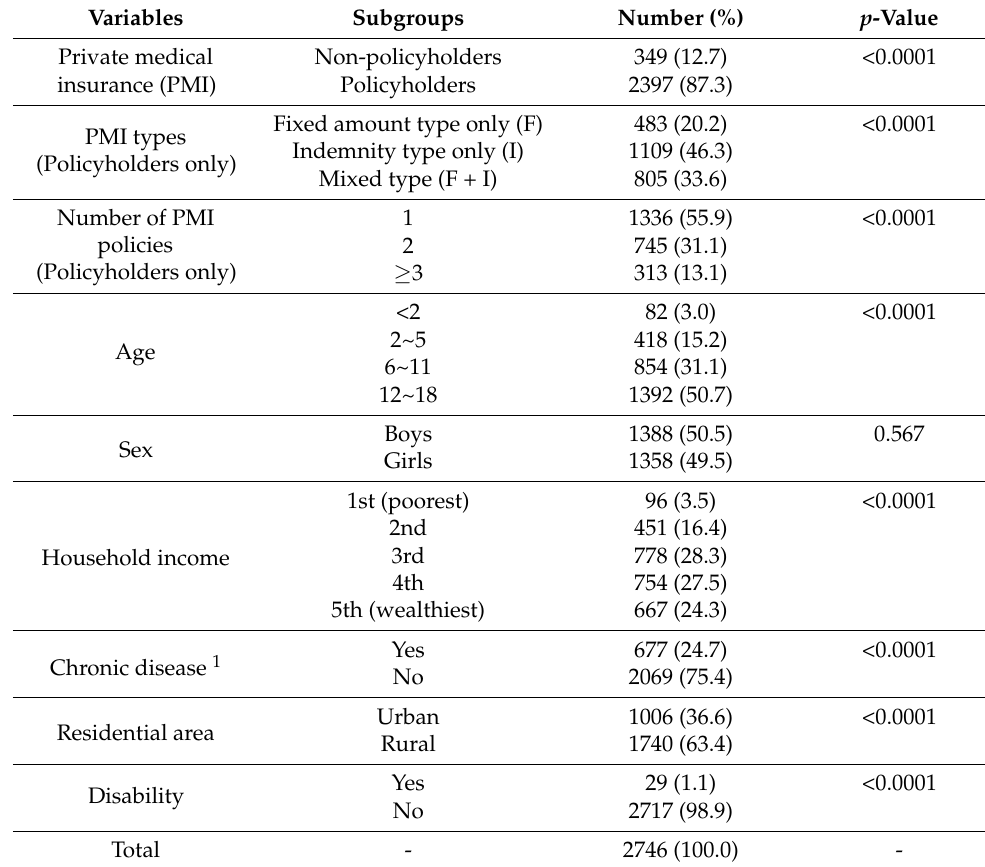
Table 1. Private medical insurance status and sociodemographic characteristics of study participants.